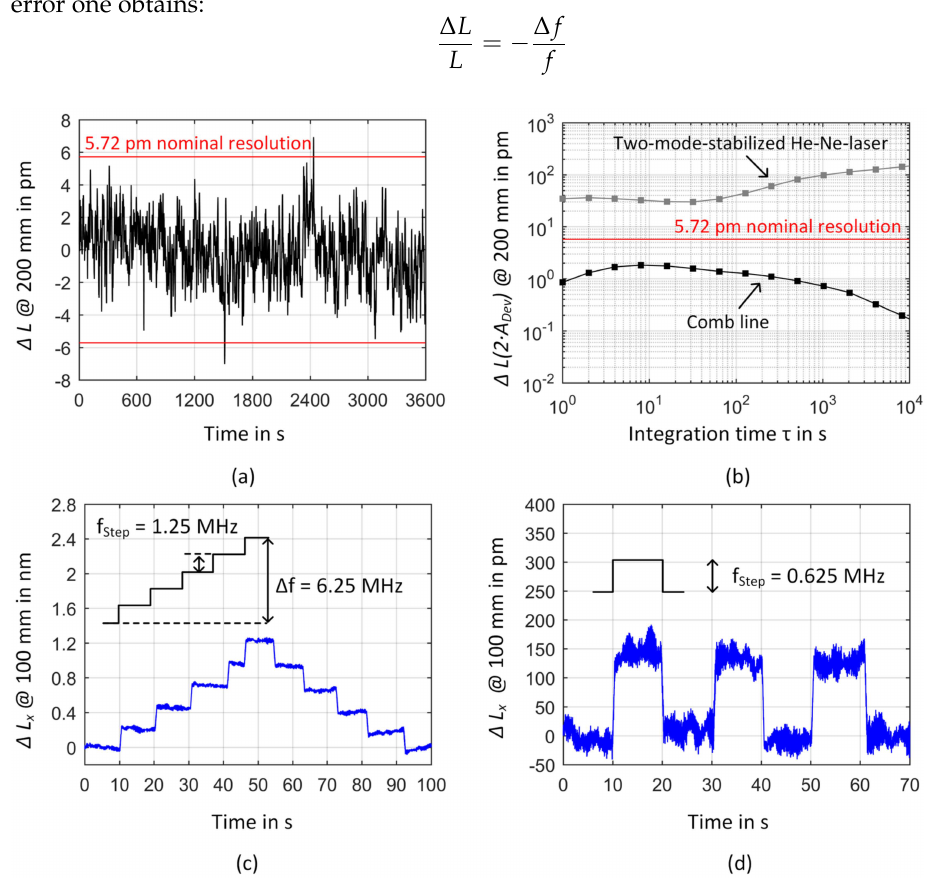
Figure 13. Influence of frequency distortions on the interferometric length measurement within the NPMM-200. ( a , b ) transform the frequency fluctuations and uncertainty of the comb line into a theoretical length measurement error for a maximum measurement range of L = 200 mm. ( c , d ) experi- mentally demonstrate the influence of frequency changes on the interferometric length measurement within the NPMM-200 at a constant distance of L = 100 mm using the comb-referenced He-Ne laser as a tunable laser source, ( c ) equidistant frequency steps of ∆ f = 1.25 MHz and ( d ) repeated frequency jumps of ∆ f = 0.625 MHz height. Integration time 0.5 s